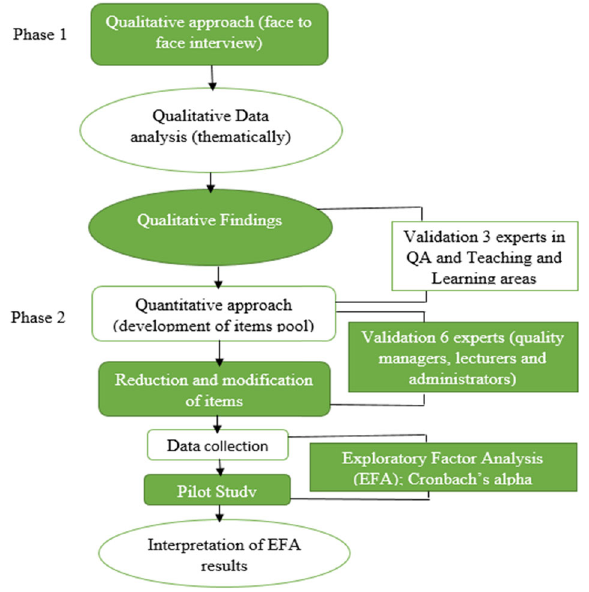
Fig. 1 Flowchart of the methodological